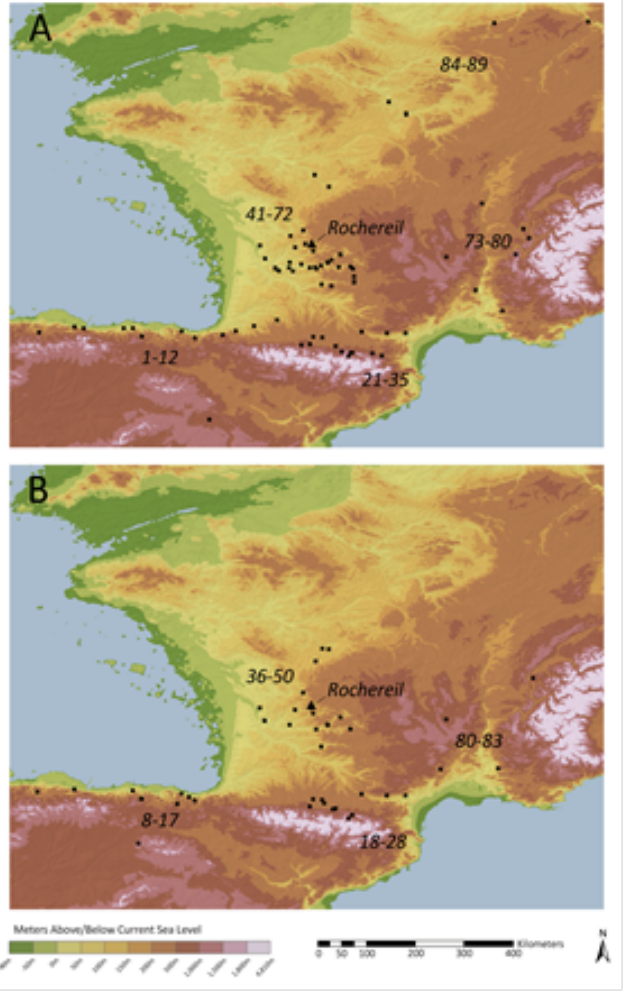
Figure 12: Distribution of Dentalium sp. (A) and Tritia reticulata (B) at Lower, Middle and Upper Magdalenian archaeological deposits across Western Europe. Map created using ETOPO1 digital relief model (Amante and Eakins 2009) and ESRI ArcMap 10.4.1. Sea levels estimated at -90m for approximately 16ka cal BP (Lambeck and Chappel 2001; Lambeck et al.